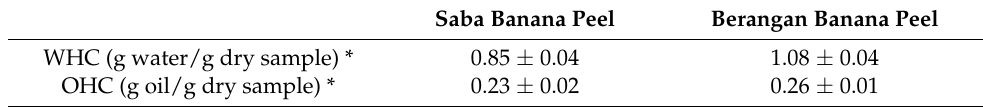
Table 3. Water-holding capacity and oil-holding capacity of Saba and Berangan BP